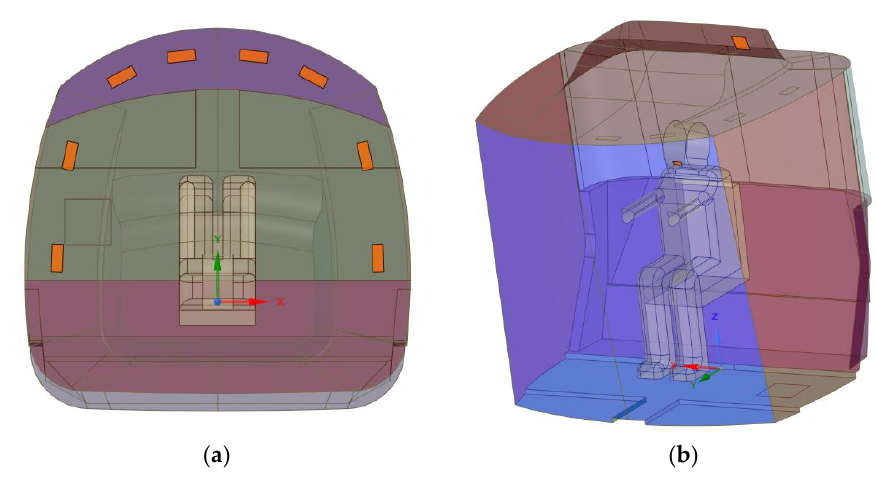
Figure 3. General scheme: ( a ) circuit inputs and ( b ) circuit output.